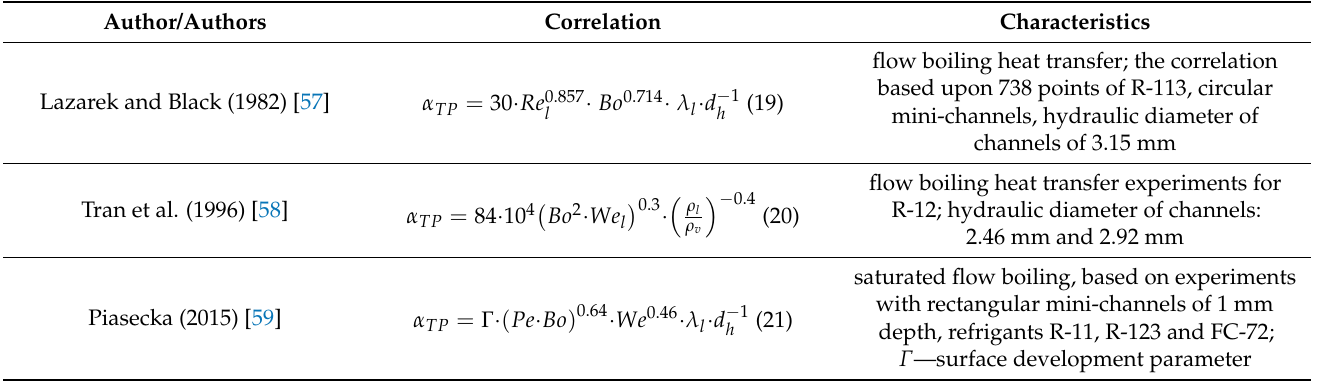
Table 4. Characteristics of selected theoretical heat transfer correlations concerning small